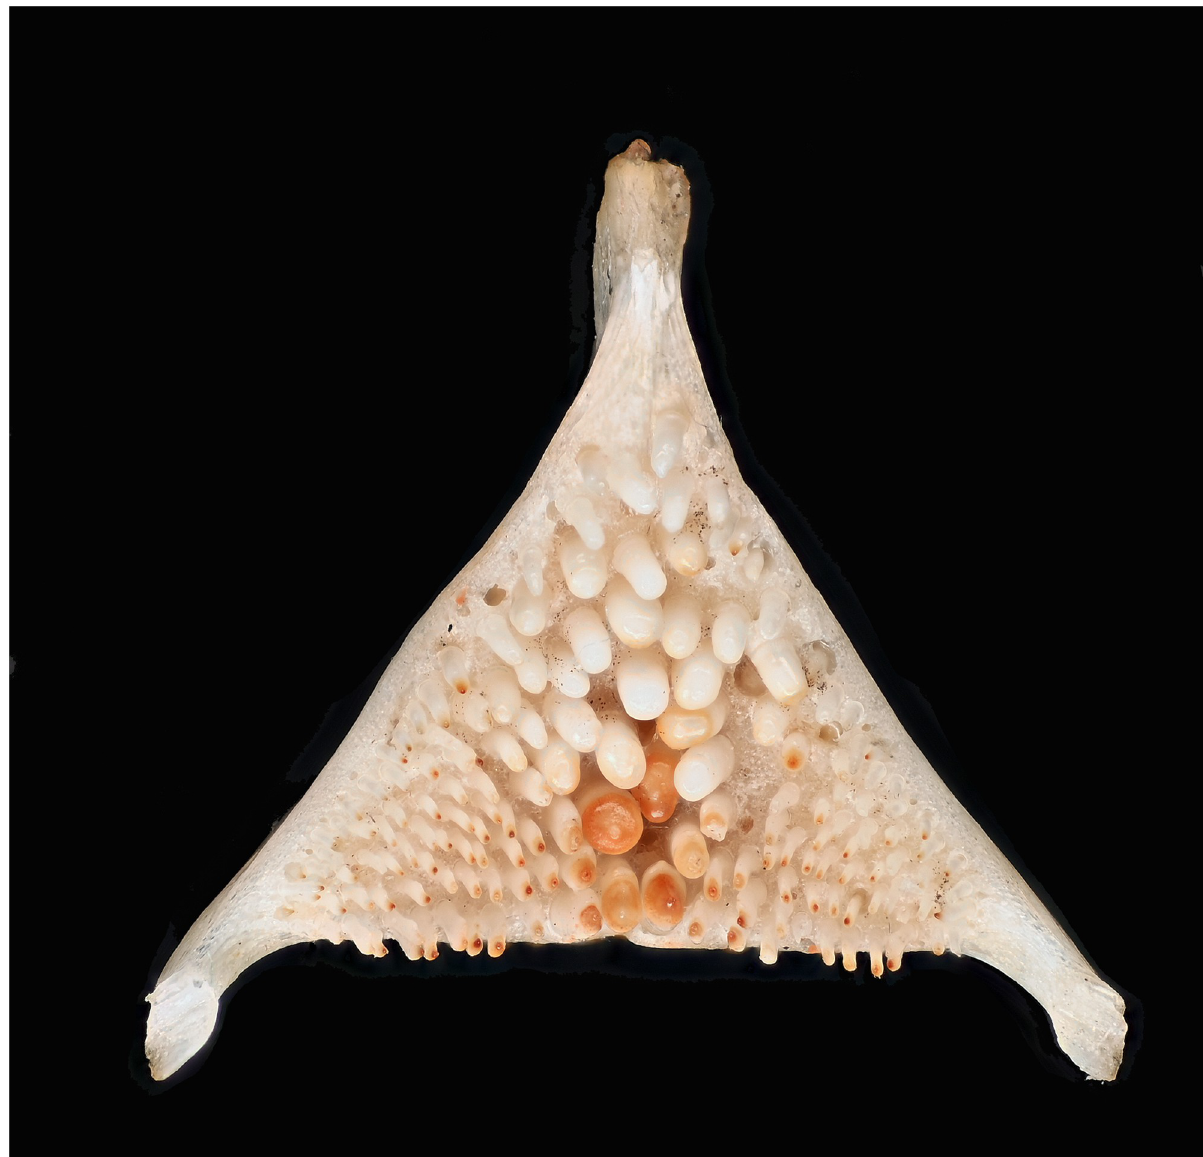
Fig 15. Australoheros facetus , NRM 55720, 100.5 mm SL; lower pharyngeal tooth plate in occlusal. larger than rest, pointed, slightly recurved; small second cusp present lingually, second row teeth much smaller than outer teeth, caniniform, at least some teeth with small second cusp lingually; teeth in third row, if present, minute, caniniform. Teeth in outer hemiseries 8–14 in each jaw. Abraded teeth absent. Lower pharyngeal tooth plate (Fig 15) relatively slender, length 70.2% of width; dentigerous area length 39% of dentigerous area width. Anterior teeth subconi- cal, slightly retrorse; 9 wide teeth in anteroposterior row along median suture, apex tuberculate on middle teeth, posterior teeth slightly compressed, bicuspid with antrorse distal cusp; laterad and posterolaterad on bone plate, teeth gradually smaller and compressed; about 19 teeth in posterior row. Microbranchiospines present externally on ceratobranchials 2–4.